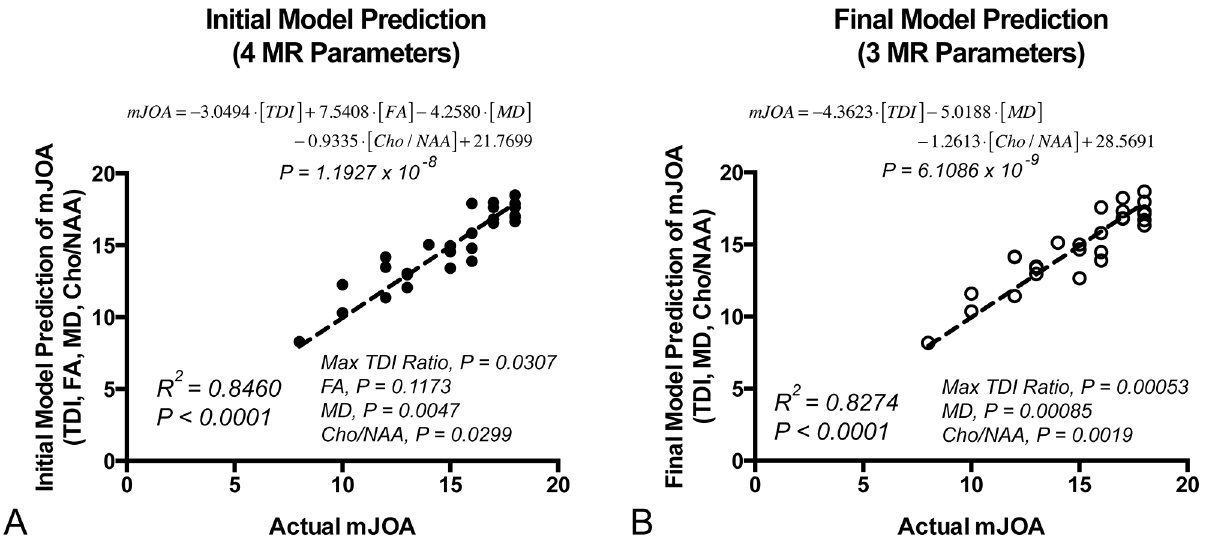
Fig 3. Initial and Final Combination Diffusion and Spectroscopic Biomarker Results for Prediction of mJOA. A) Initial model consisting of four MR measurements found to be individually correlated with mJOA. Note that results suggested FA at the site of compression did not add significant predictive value to the model. B) Final model consisting of three MR measurements (excluding